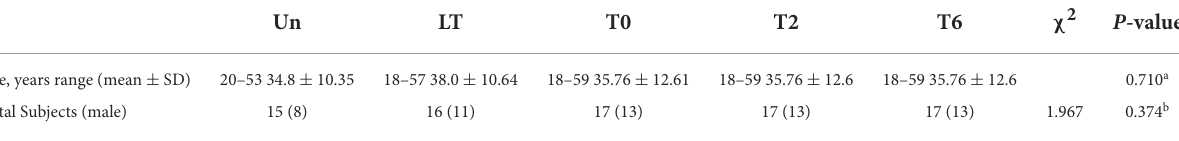
TABLE 1 Characteristic of pulmonary TB patients during the therapy, latent tuberculosis infection and healthy